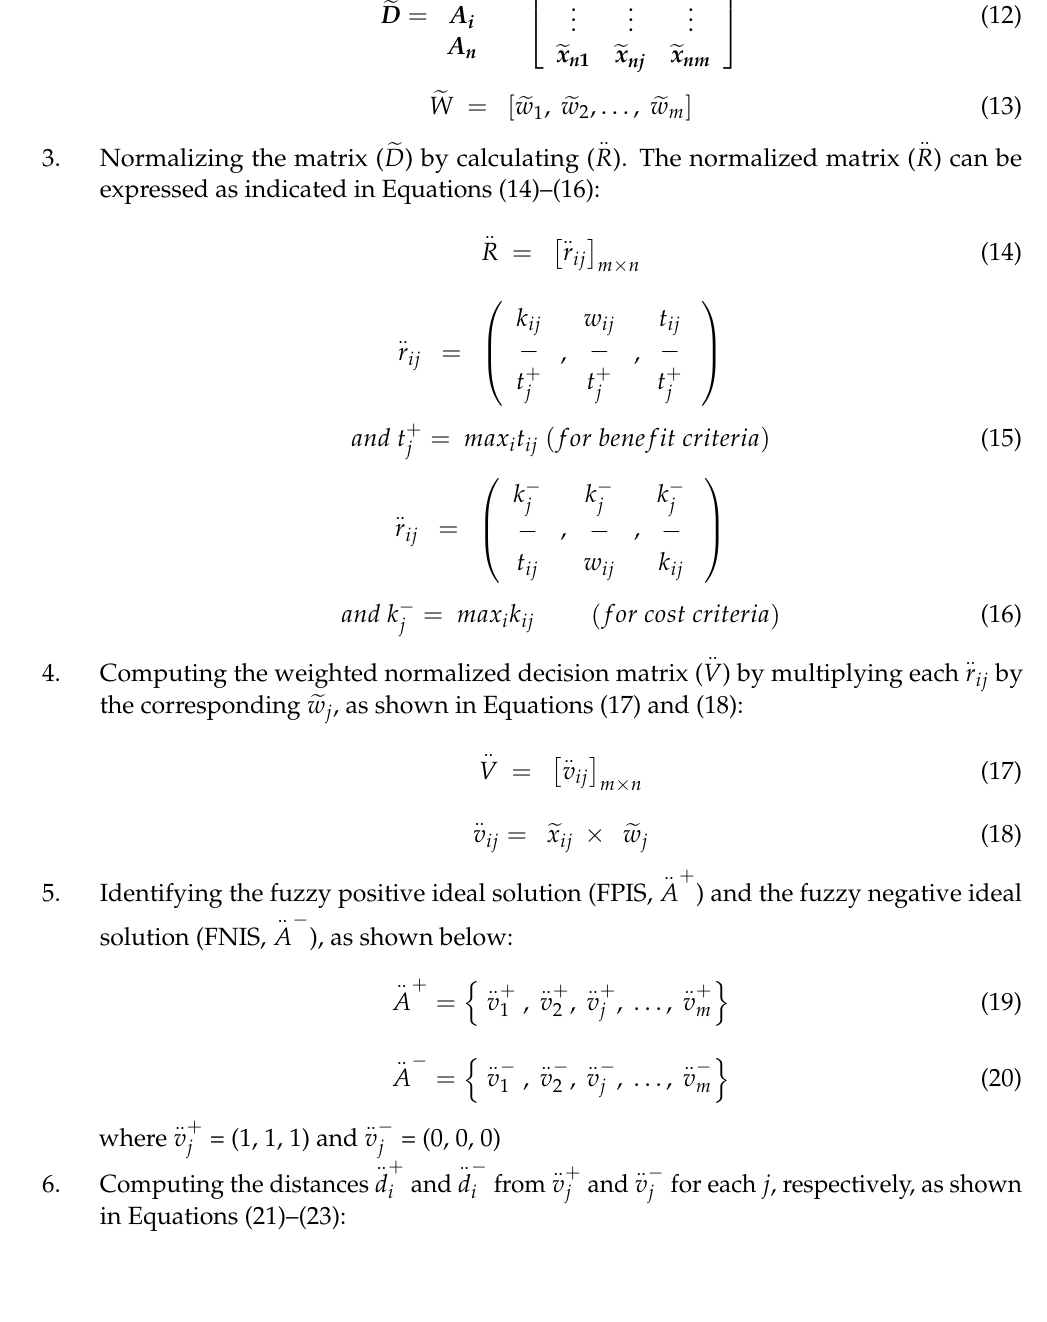
where in Equations